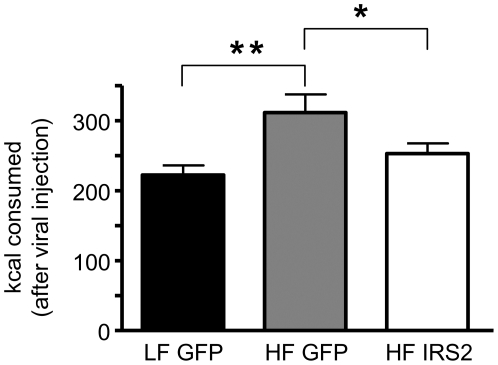
HF feeding results in more calories consumed, an effect reversed by viral injection of IRS2.Caloric consumption of rats used in experiments in Fig. 7 was calculated over the three day, post-injection period. (LF GFP, n = 11; HF GFP, n = 18; HF IRS2, n = 13; **p<0.01; *p<0.05 by one-way ANOVA, followed by Newman-Keuls multiple comparison test). Data represented are the mean ± S.E.M.